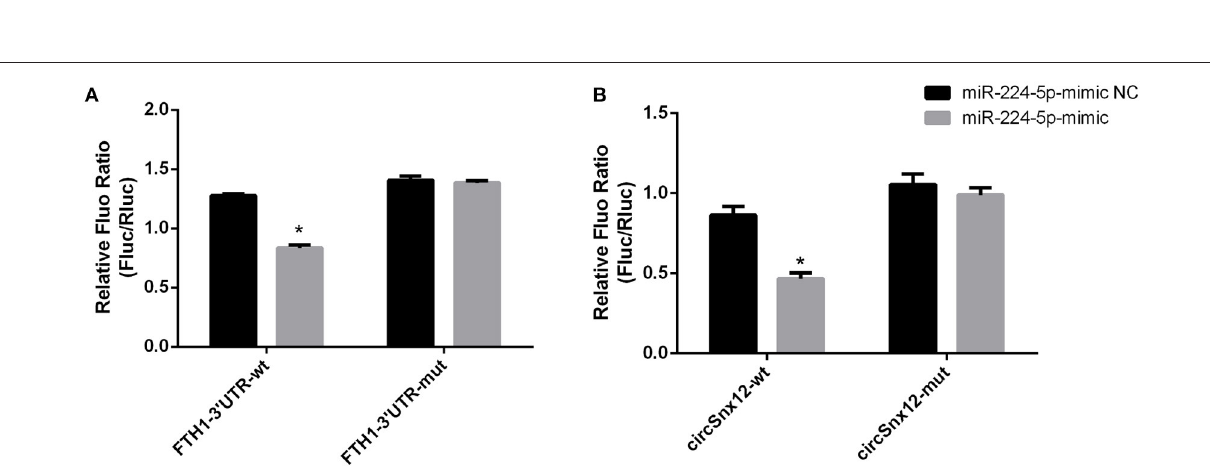
Frontiers in Cardiovascular Medicine |